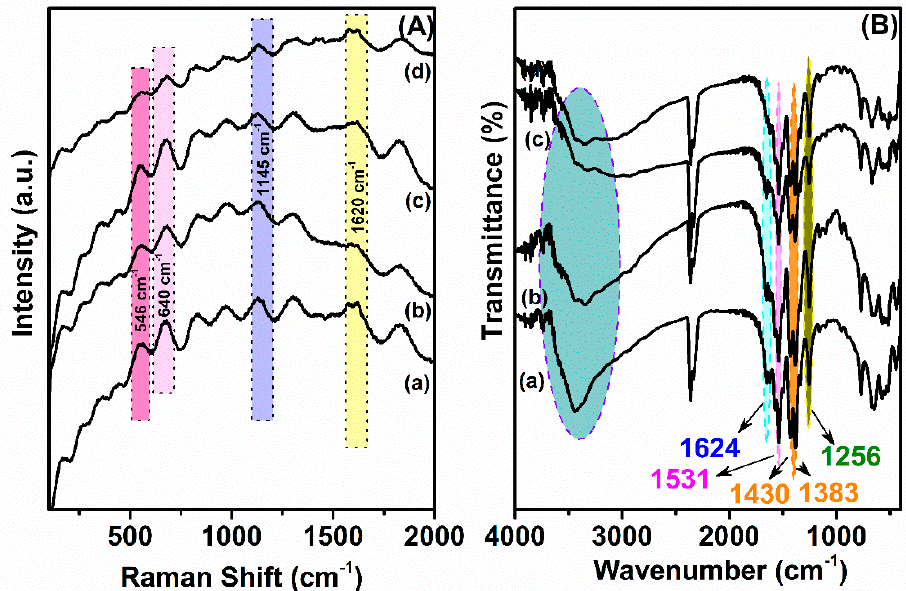
Figure 2. Raman spectra ( A ) and FT-IR spectra ( B ) of NH 2 -MIL-125(Ti) (a), 15% Ni/Ti-MOFs (b), 15% Co/Ti-MOFs (c), and 15% Fe/Ti-MOFs (d).